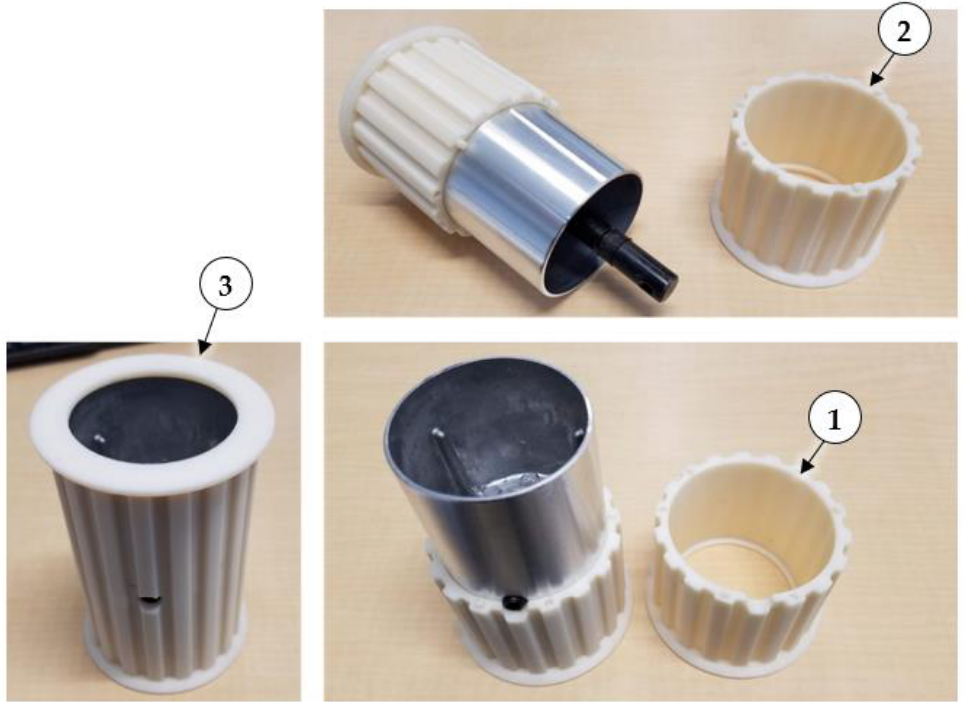
Figure 4. Split mating halves of 3D printed (1) drive and (2) idler pulleys, and (3) drive pulley halves assembled and glued onto aluminum drive pulley.